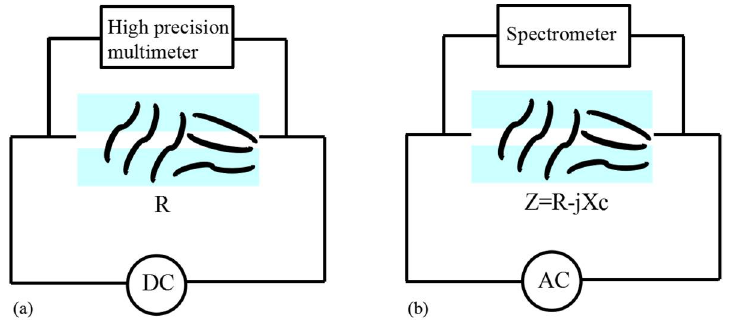
Figure 4. Schematic diagram of sensitivity test of CNT/PDMS force-sensitive structure ( a ) under DC conditions ( b ) under AC conditions.